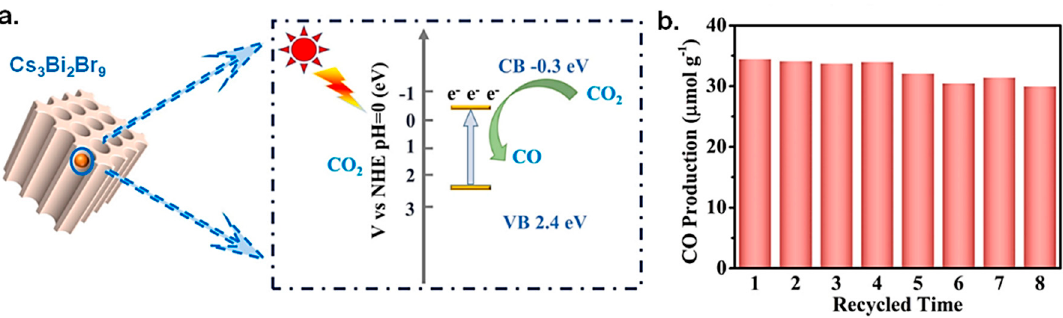
Figure 9. ( a ) Schematic representation of the encapsulation of Cs 3 Bi 2 Br 9 on MCM-41 and ( b ) cycling experiment tests. Adapted from [142].